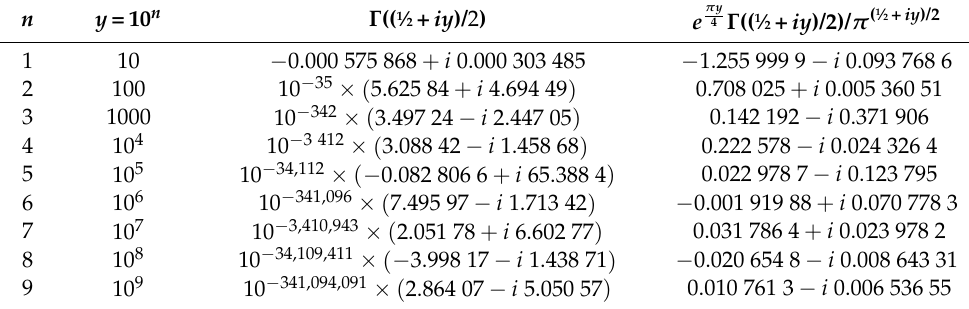
Table 3. Regularization of the gamma function to restrict the spectrum of values.